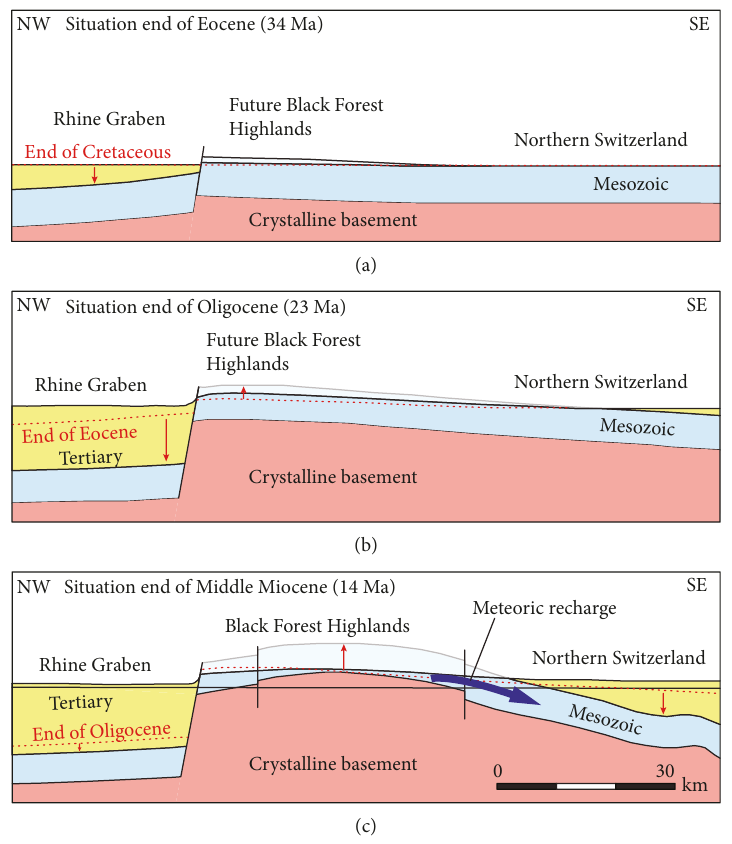
Figure 3: Schematic erosional history along a NW – SE section through the Black Forest Highlands. Middle Miocene exhumation of the Mesozoic (including basal Triassic) sequences and the crystalline basement provided recharge areas for meteoric water (modi fi ed after Thury et al.